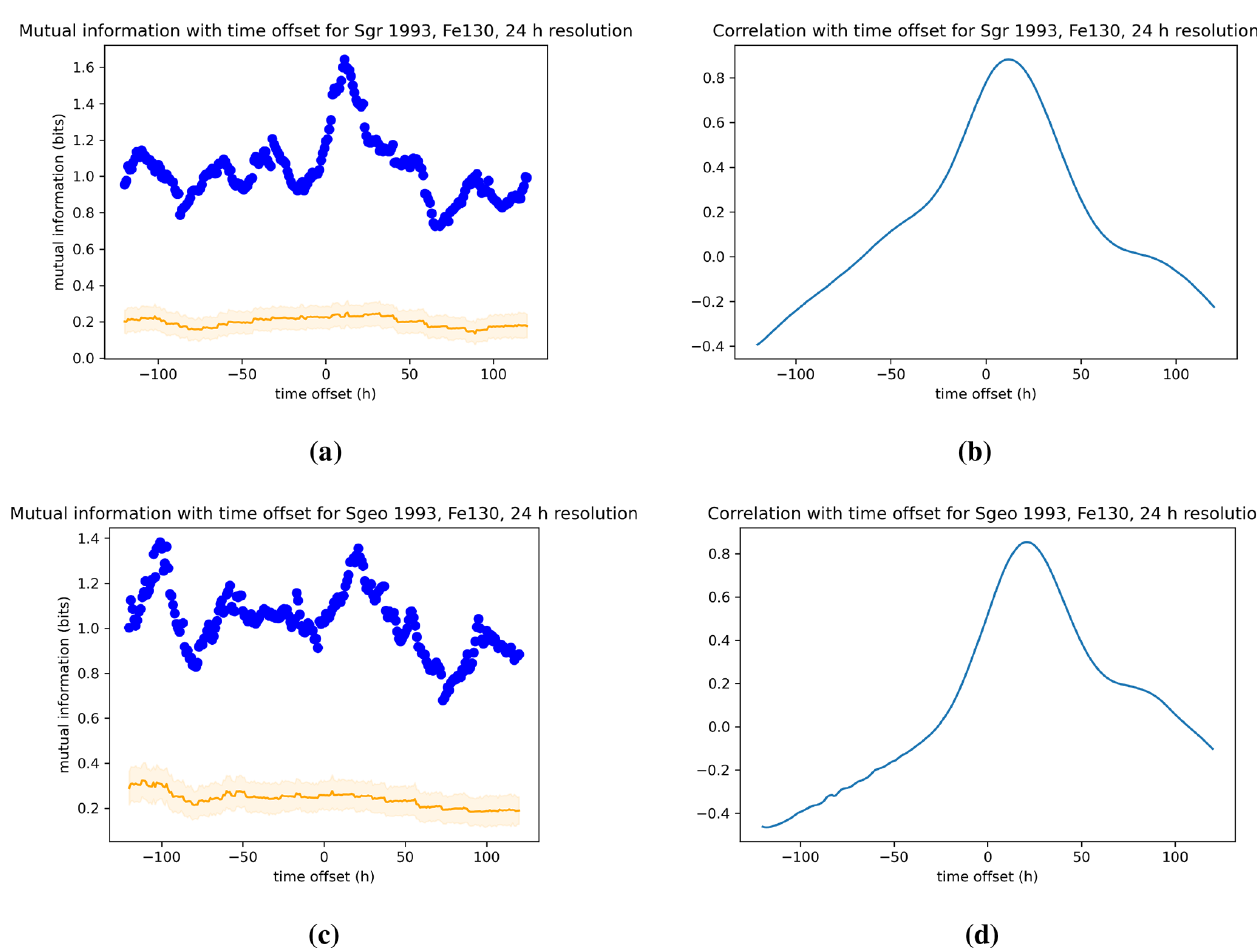
Figure 11. Same as in Fig. 9 but with a 24h moving